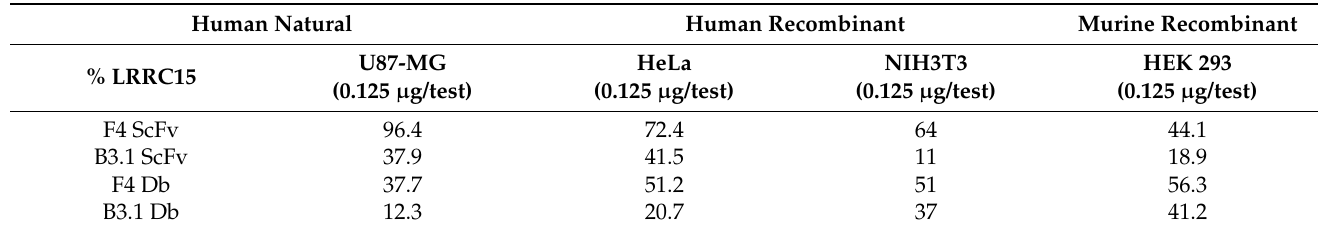
Table 6. Summary of small recombinant antibodies specific to cell line, measured by flow